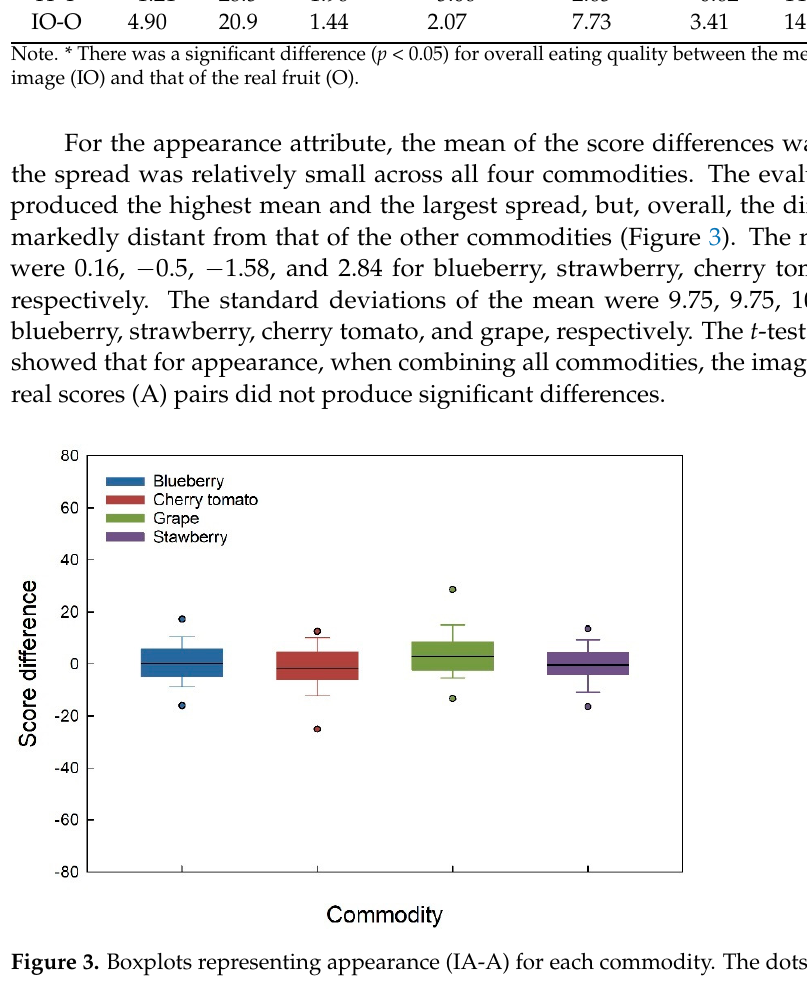
Table 1. Paired t -test comparing sensory mean score of images to real produce under different conditions across all commodities.